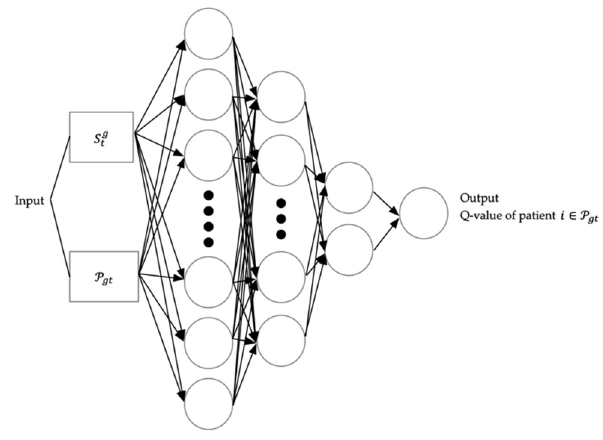
Figure 1. Architecture of the deep Q -network to generate Q -value for each patient. Figure 1. Architecture of the deep (cid:1843) -network to generate (cid:1843) -value for each patient. Figure 1. Architecture of the deep (cid:1843) -network to generate (cid:1843) -value for each patient.